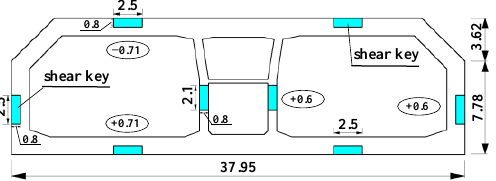
Figure 7. Typical structural section of segment joint in immersed tunnel (unit: m).